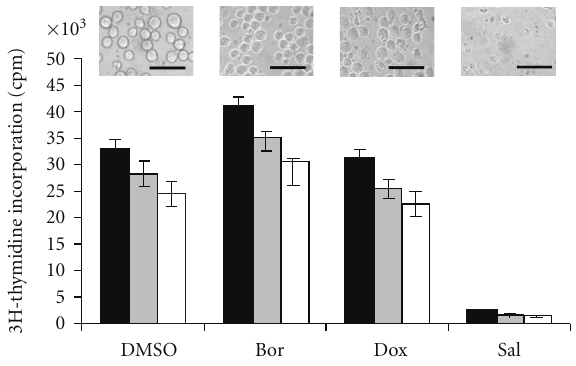
Figure 2: Salinomycin does not permit long-term adaptation and development of resistance of KG-1a AML SCs to apoptosis-inducing concentrations of salinomycin (Sal, 10 μ M), whereas the cells could be readily adapted to survive and to proliferate in the presence of initially apoptosis-inducing concentrations of doxorubicin (Dox, 0.5 μ g/mL) and bortezomib (Bor, 12.5 nM). After 12 weeks of culturing in the presence of 12.5nM Bor, 0.5 μ g/mL Dox, 10 μ M Sal, or DMSO 5% (v/v), proliferation of the cells was determined by [ 3 H] thymidine incorporation for 24h. White bars: KG-1a AML SCs; grey bars: KG-1a AML cells; black bars: KG-1 AML cells. Inserts show invert microscopic pictures (400x) of KG-1a AML SCs cultured for 12 weeks in the presence of the drugs noted below. Size bars are 50 μ m. Adapted from [16], with permission from